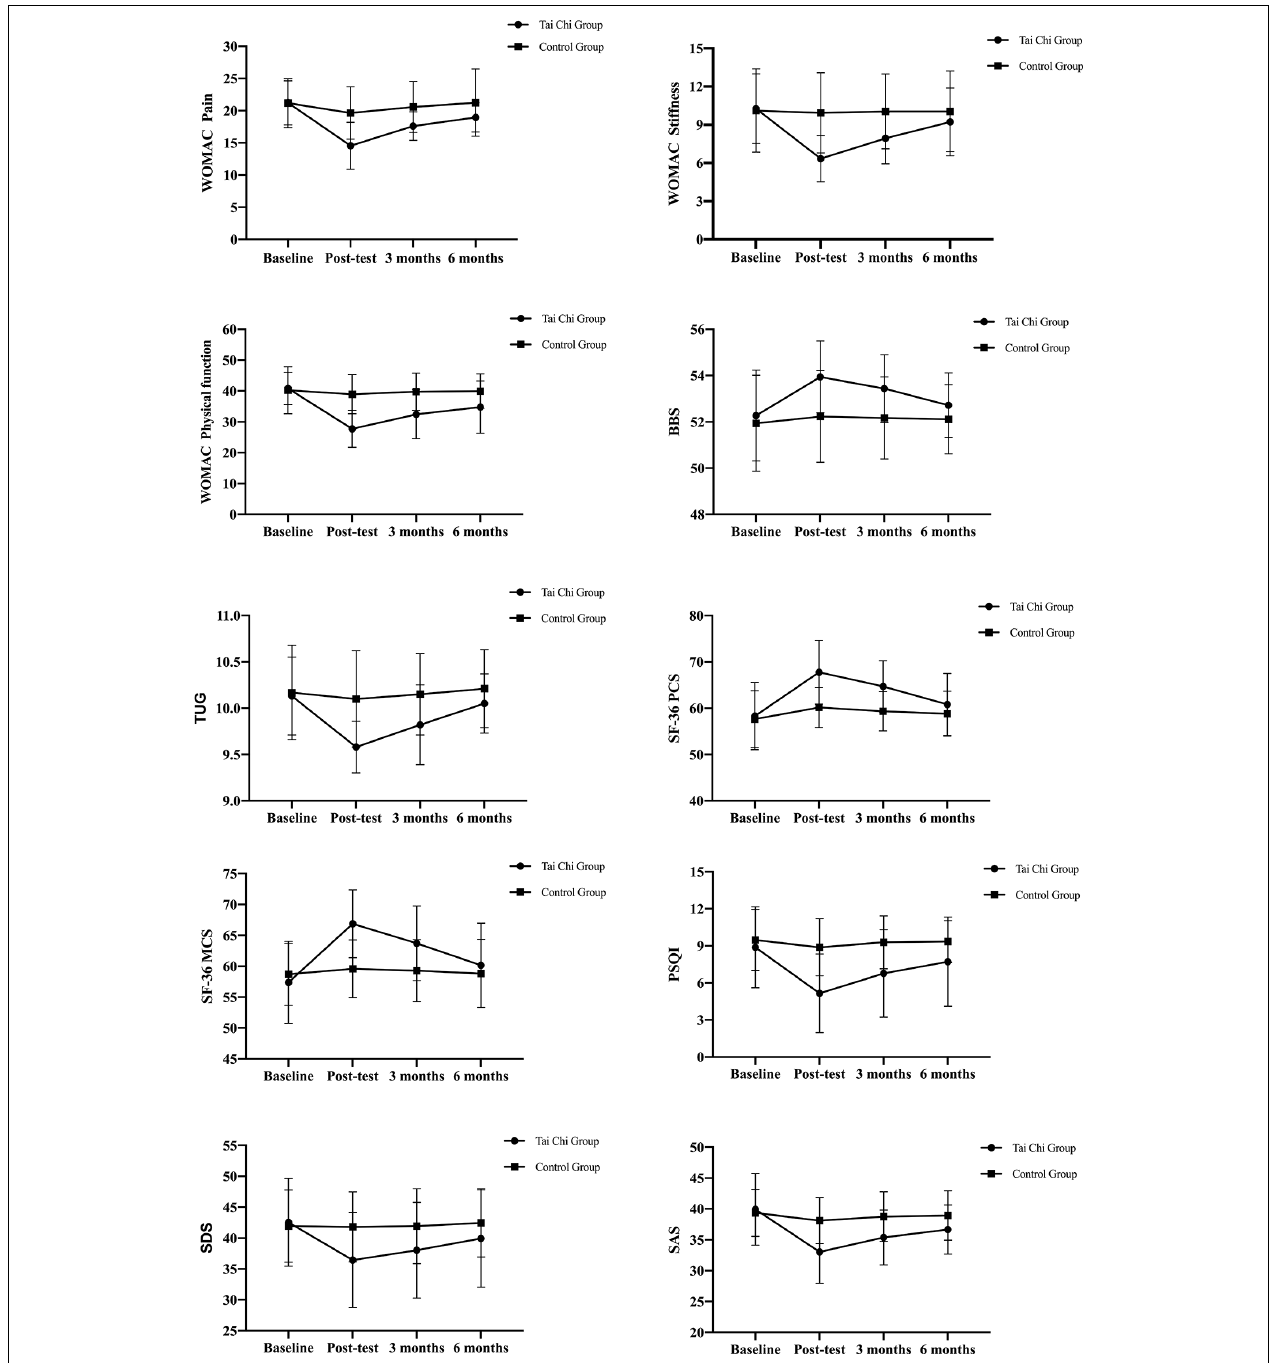
FIGURE 2 | The changes in the indicators of the two groups at Baseline, 12 weeks, follow-up 3 months, and 6 months over time. The value is the mean ± standard deviation (SD); error bars show the 95% confidence interval. WOMAC, The Western Ontario and McMaster Universities Osteoarthritis Index; BBS, Berg balance scale; TUG, time up go; SF-36, The MOS item short-form health survey; MCS, Mental component summary; PCS, Physical component summary; PSQI, Pittsburgh sleep quality index; SAS, Self-rating Anxiety Scale; SDS, Self-rating Depression